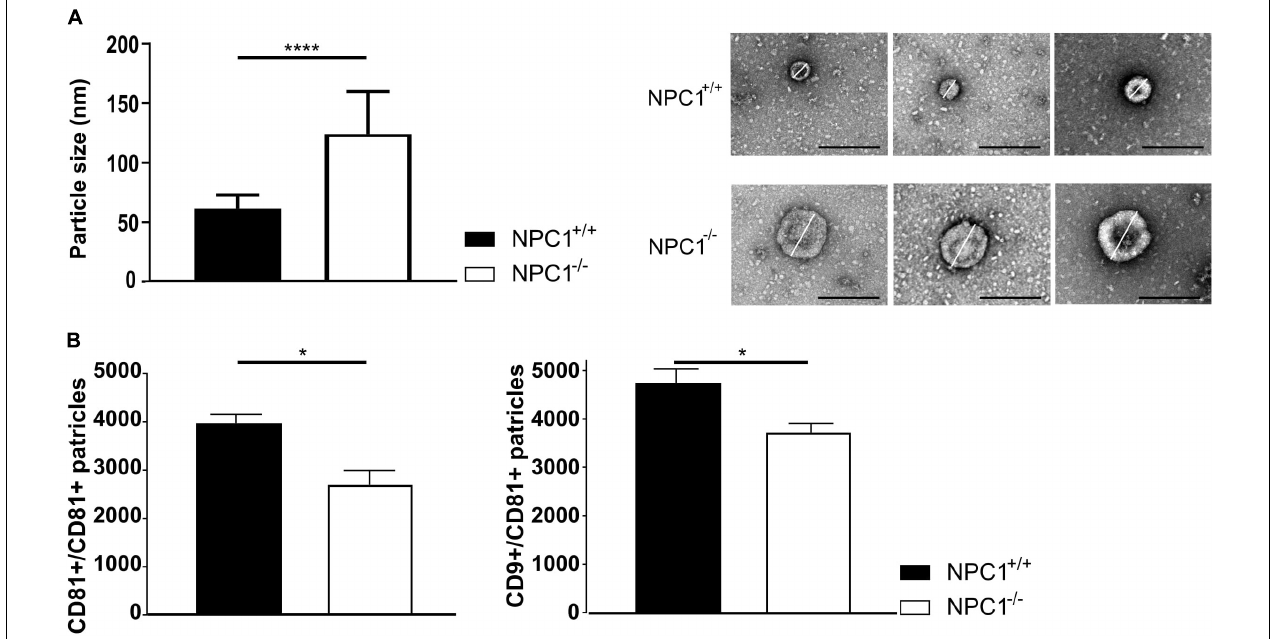
FIGURE 4 | NPC1 − / − mice contain larger and less CSF extracellular vesicles (EVs). (A) Average size and representative negative staining transmission electron microscopy (TEM) images of CSF EVs from 9 weeks old NPC1 + / + (black; n = 30) and NPC1 − / − (white: n = 30) mice. Scale bar represents 500 nm. The size represents the mean ± SEM of 30 EVs per condition. (B) ExoView analysis of the amount of CD81 captured and CD9 captured–CD81 positive EVs in CSF of NPC1 + / + and NPC1 − / − mice of 9 weeks old mice. Bar represent mean ± SEM of four biological replicates. For each biological replicate, the presented result is the average from three technical replicates on the chip. Data are shown as a mean ± SEM. Statistical analyses on datasets were performed by Mann–Whitney test. Asterisks indicate statistical significance (* p < 0.05 and **** p < 0.0001, ns: